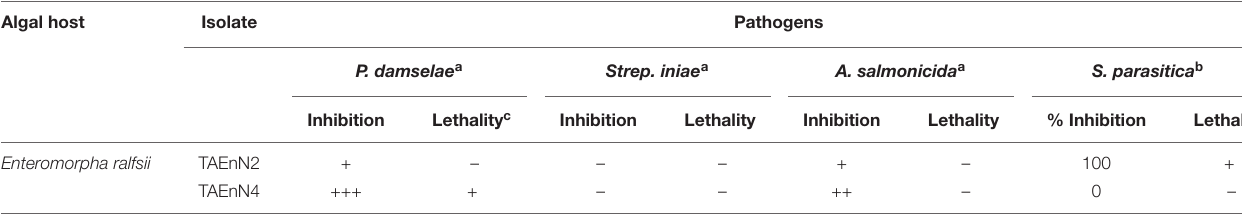
( Table 1 ). Comparison of the number of bacterial endophytes isolated from the same genus of alga from the different locations revealed variations according to the sampling location.